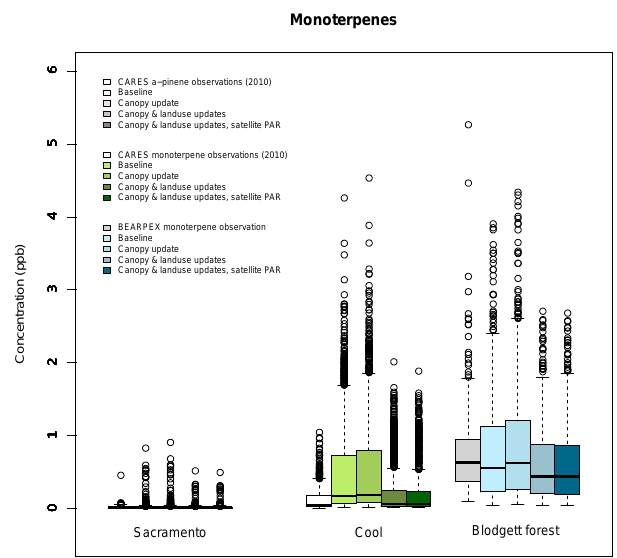
Figure 7. Distribution of observed and modeled monoterpenes. Ob- servations at Sacramento and Cool represent June 2010. Observa- tions at Blodgett Forest match the modeled